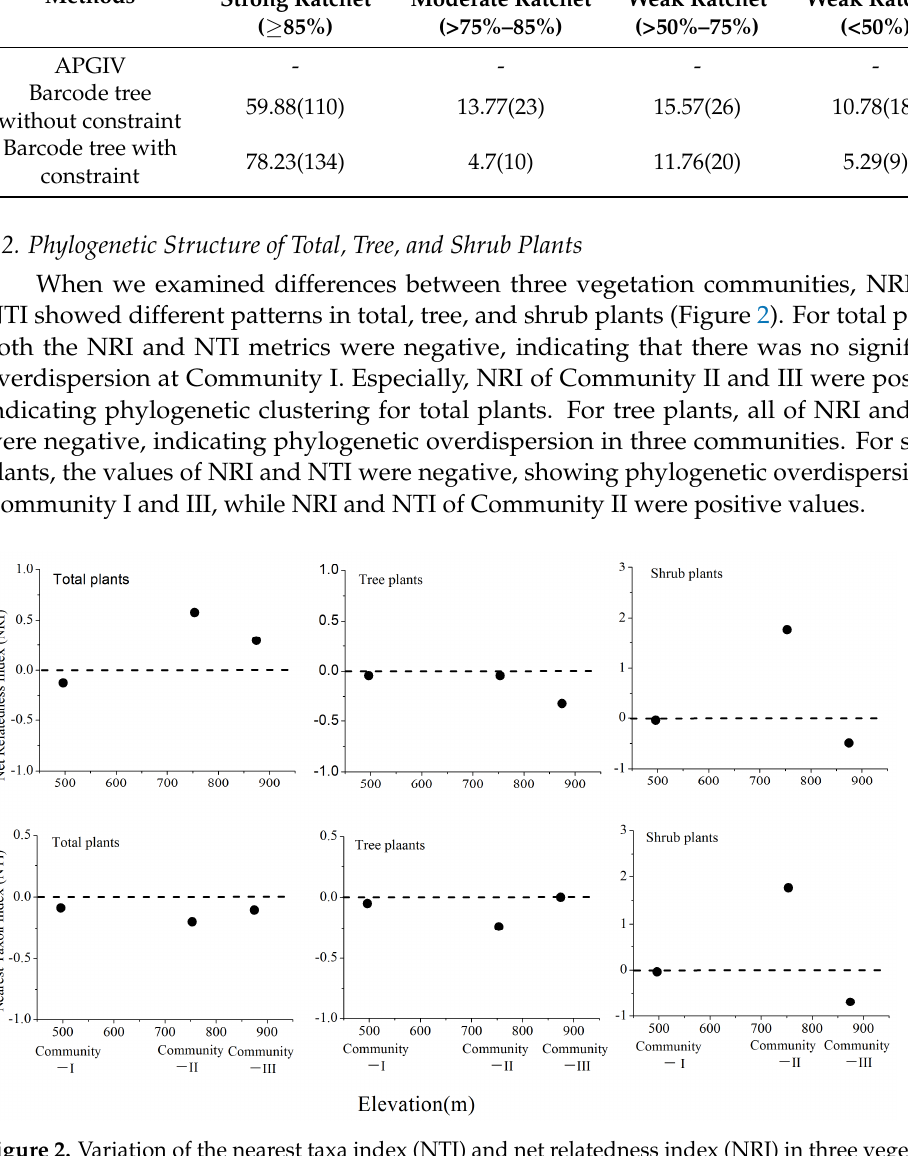
Figure 2. Variation of the nearest taxa index (NTI) and net relatedness index (NRI) in three vegetation communities for total plants, trees, and shrubs at Mt. Huangshan.